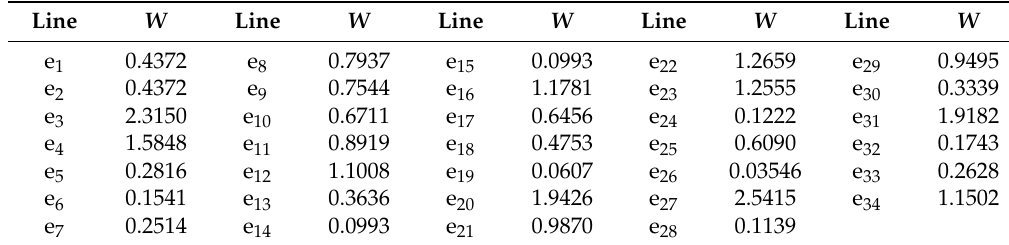
Table 5. Calculation result of transmission lines.